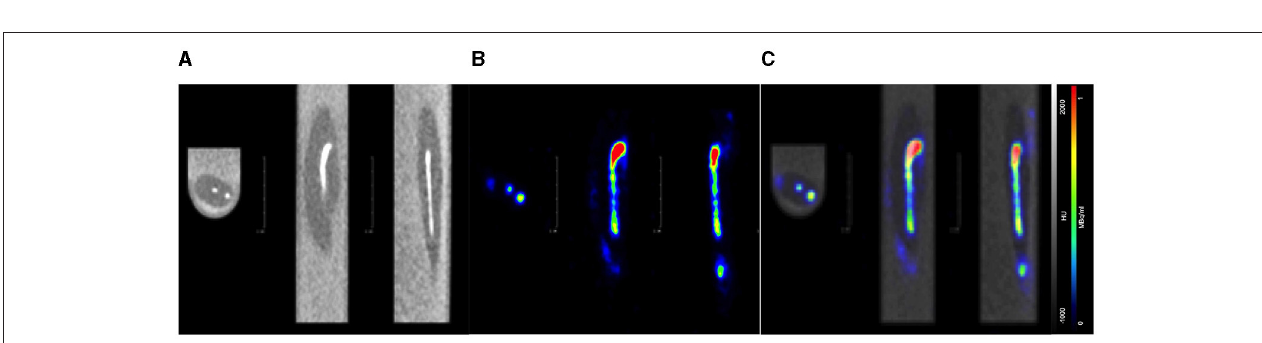
FIGURE 3 | Sagittal PET/CT image acquisition of the 3D printed zebrafish model post-injection of 0.01 MBq of [ 18 F]FDG. [ 18 F]FDG is seen within the 1mm simplistic vascular system, though substantial amounts remained at the injection site (white arrows). Adjustments to the injection procedure were made allowing for improve follow in the hollow plastic cavity.